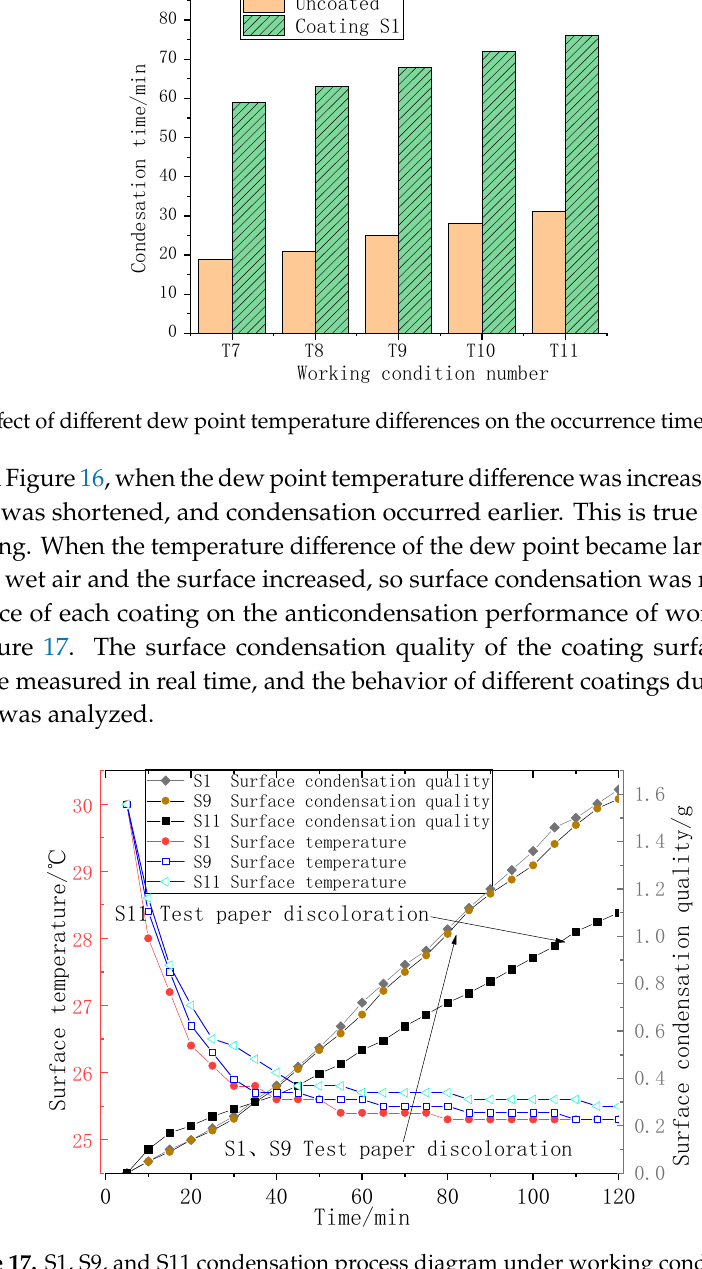
Figure 17. S1, S9, and S11 condensation process diagram under working condition T11.